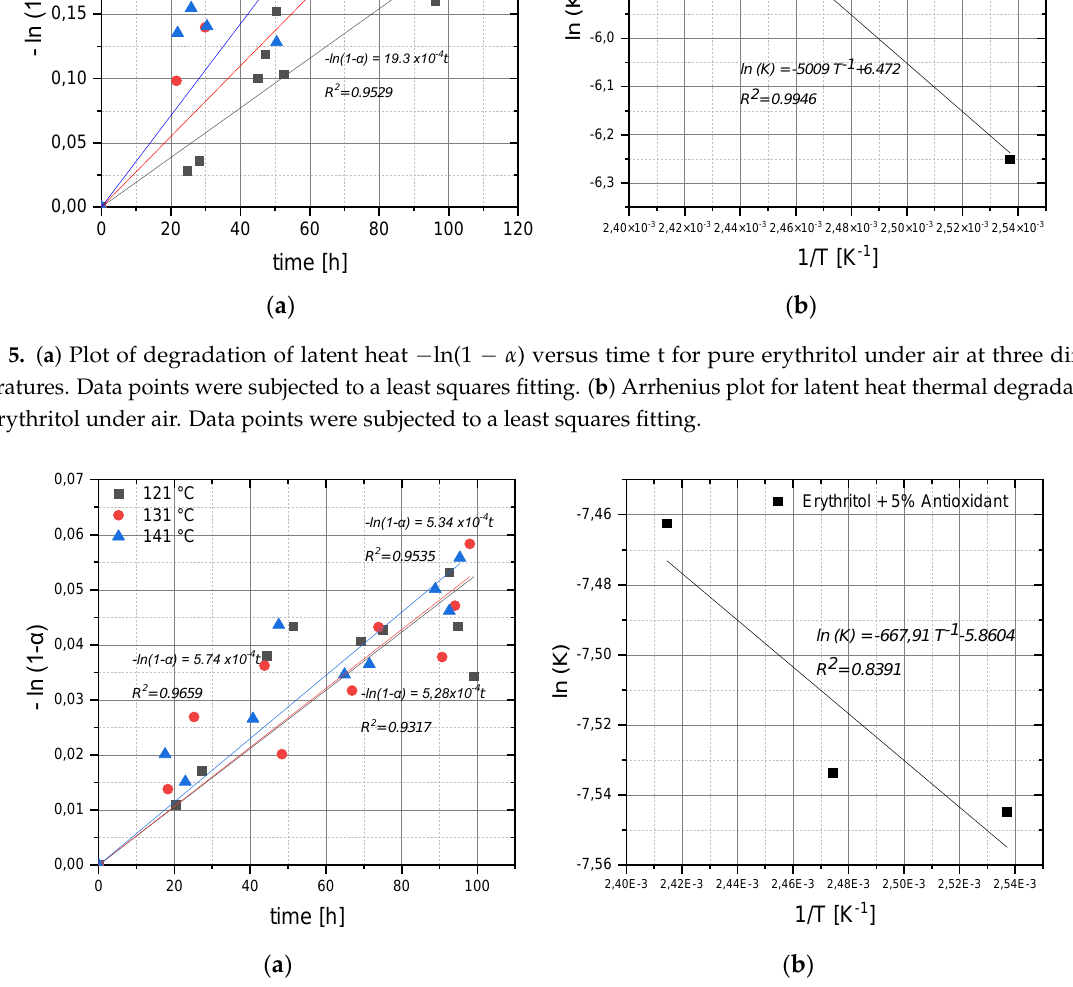
Figure 6. ( a ) Plot of degradation of latent heat −ln(1− α ) versus time t for erythritol with antioxidant under air at three different temperatures. Data points were subjected to a least squares fitting. ( b ) Arrhenius plot for latent heat thermal degradation of erythritol with antioxidant under air. Data points were subjected to a least squares fitting.